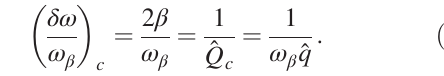
FIG. 13. Power evolution in XFELO-A with (a) R ¼ 0 . 8333 ð ˆ q ¼ 5 Þ , and (b) R ¼ 0 . 75 ð ˆ q ¼ 3 Þ subject to periodic misalign- ments with single frequency between 0.77 and 1.46 times the Betatron frequency with an amplitude of crystal tilt of − 45 nrad. The y axis is on a log 10